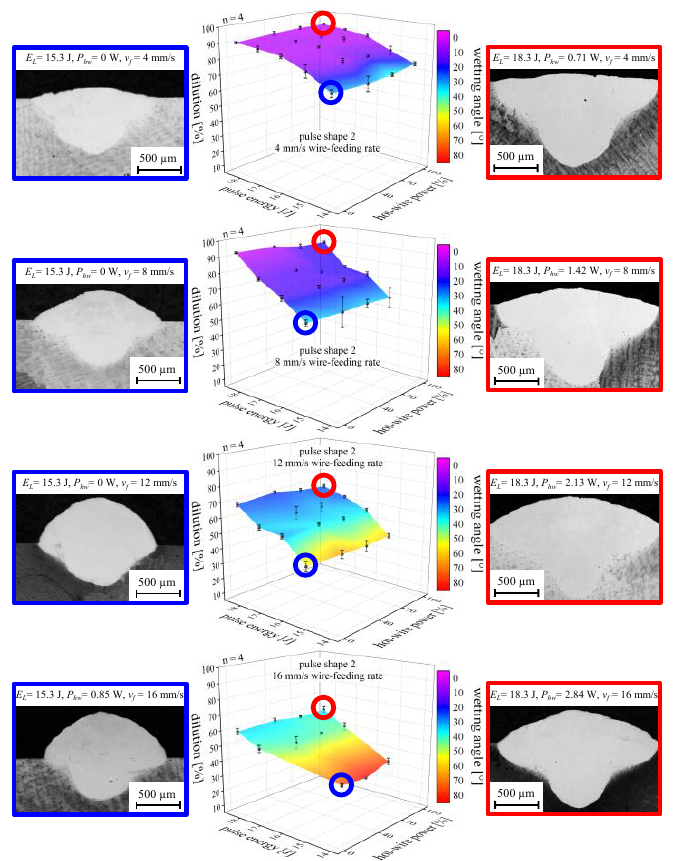
Figure 13. Dilution as function of pulse energy and hot-wire power for pulse shape 2 and wire-feeding rates of 4 mm/s, 8 mm/s, 12 mm/s and 16 mm/s. Blue marked data points and corresponding micrographs belong to the lowest energy input (laser and hot-wire), and red marked data points and corresponding micrographs belong to the highest energy input (laser and hot-wire).The hot-wire power is given in percent in the diagrams and with absolute values in the header of the micrographs.